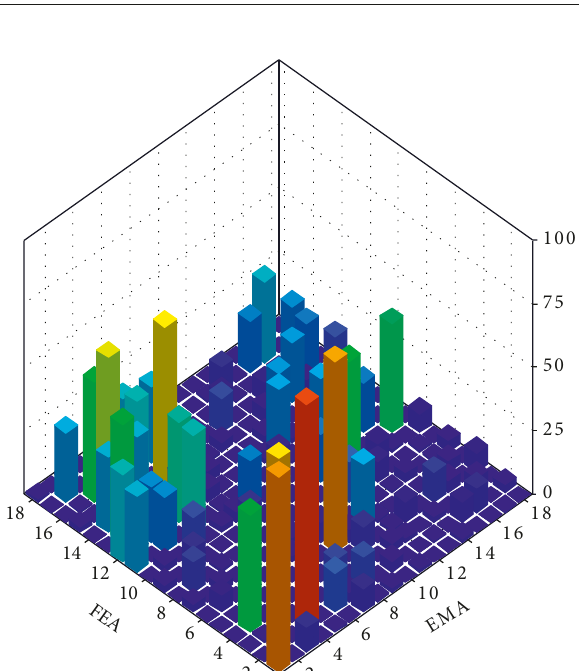
Figure 6: MAC before updating.